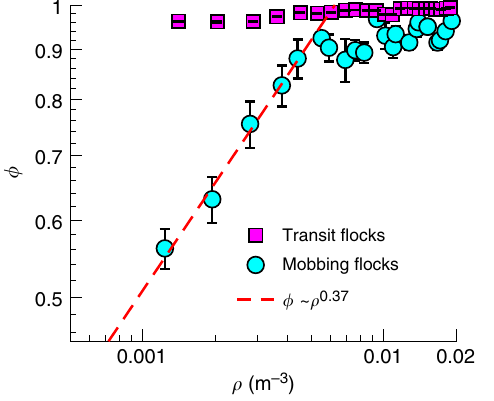
Fig. 3 Relationship between group density and group order. For the mobbing fl ocks, results are calculated by averaging the results from 154 groups of jackdaws over a total of 36,960 time frames. Error bars represent standard errors. Distributions of group density ρ and group order ϕ for the 154 groups can be found in Supplementary Fig. 6. For the transit fl ocks, results are calculated by averaging 30,498 samples, where each sample represents a local subgroup of one focal bird and four nearest neighbours embedded in a larger fl ock. Data for subgroups with sizes of 10 and 20 for transit fl ocks are shown in Supplementary Fig.